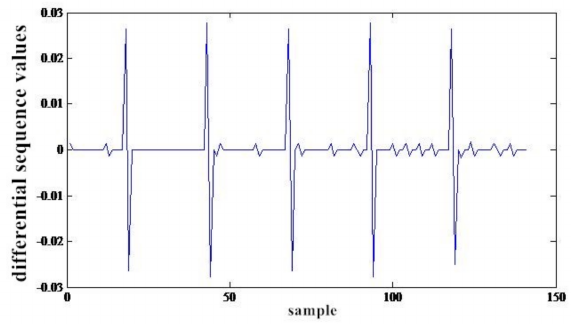
Figure 6. Three-step differential sequence.